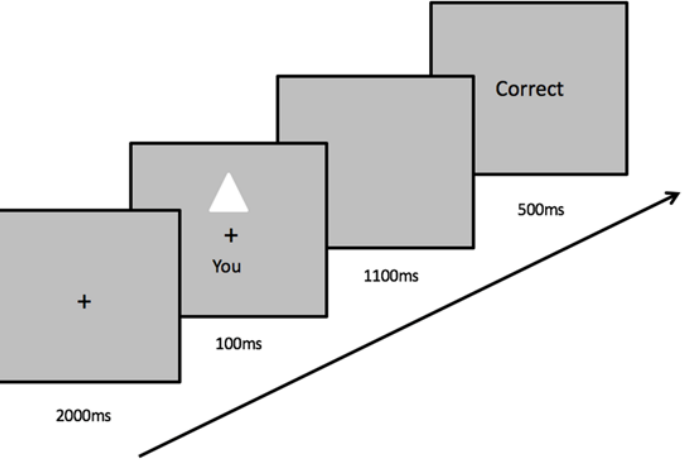
Figure 2. A trial procedure and an example of stimuli in the matching task. Participants responded by making judgments on whether the shape-label pair displayed onscreen is the correct association or